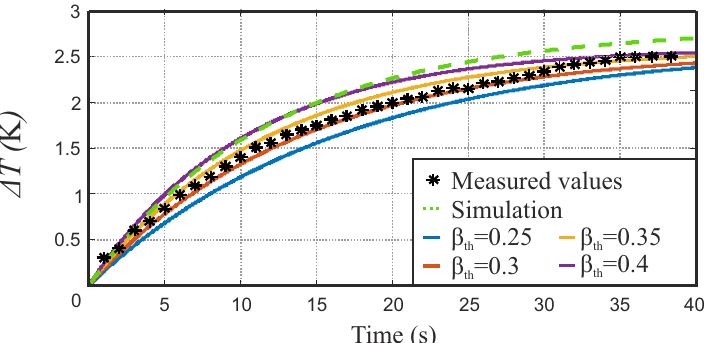
Figure 9. Transient temperature observation of the investigated waveguide’s center, indicat- ing the FRMWT model for different model parameters (solids), simulation results (– –) and measurement results ( ∗ ).